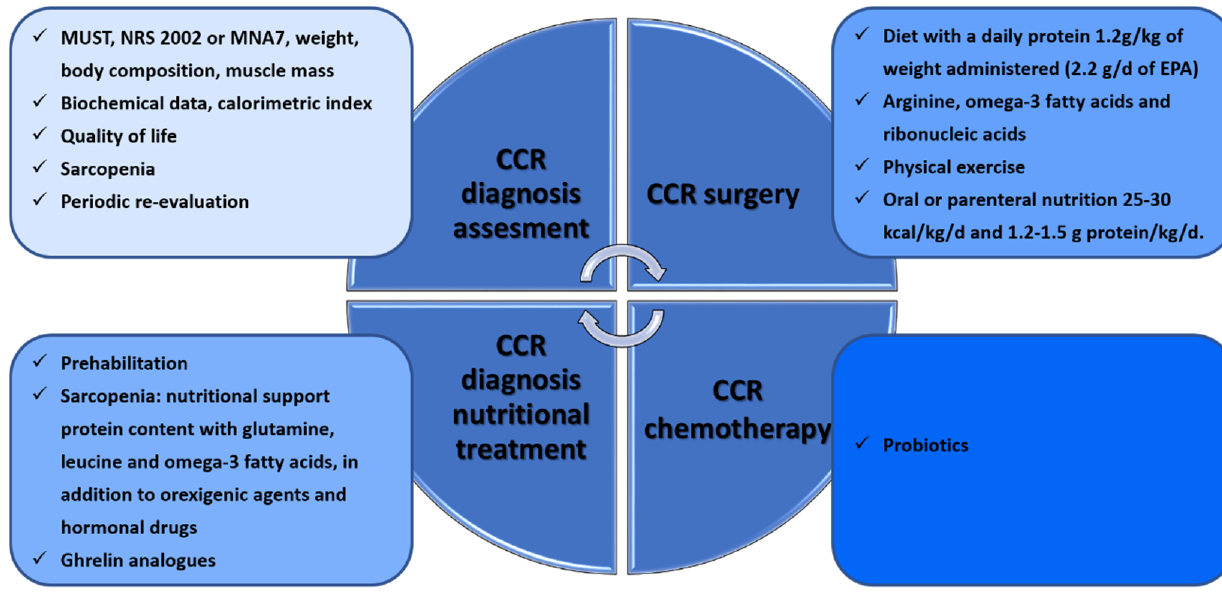
Figure 4. Workflow of nutritional interventions during CRC diagnosis and under surgery or chemotherapy therapies.